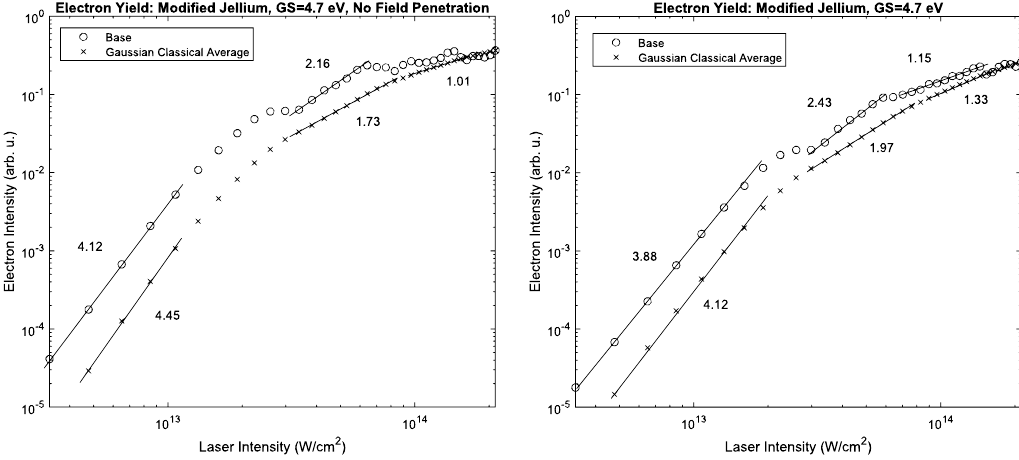
Figure 10. Simulated electron yield using a modified potential with incident laser wavelength of 800 nm. The electrostatic potential (excluding the external field) was scaled such that the ground state was at –4.7 eV, a much more reasonable value for a metal’s work function. The yields with ( Right ) and without ( Left ) field penetration are shown. The individual simulated yields are shown as o’s and the integrated yields (averaged over a 2D Gaussian intensity profile) are shown as x’s. Experiments have shown power laws of about 2.5, tapering to 1 [15]. While we do not see those exact values here, we do see regime transitions. Note that the reported laser intensity is the enhanced intensity as opposed to